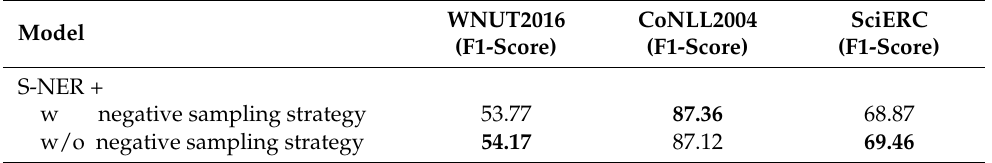
Figure 3. Performance comparisons on the dev sets of the three benchmark datasets when setting the negative span count δ to various values. We set δ to 100 in all other experiments. Table 3. Performance comparisons under the conditions of using and not using the randomly sampling strategy. We report the performance on the dev sets of the three benchmark datasets. Bold values denote the best results.